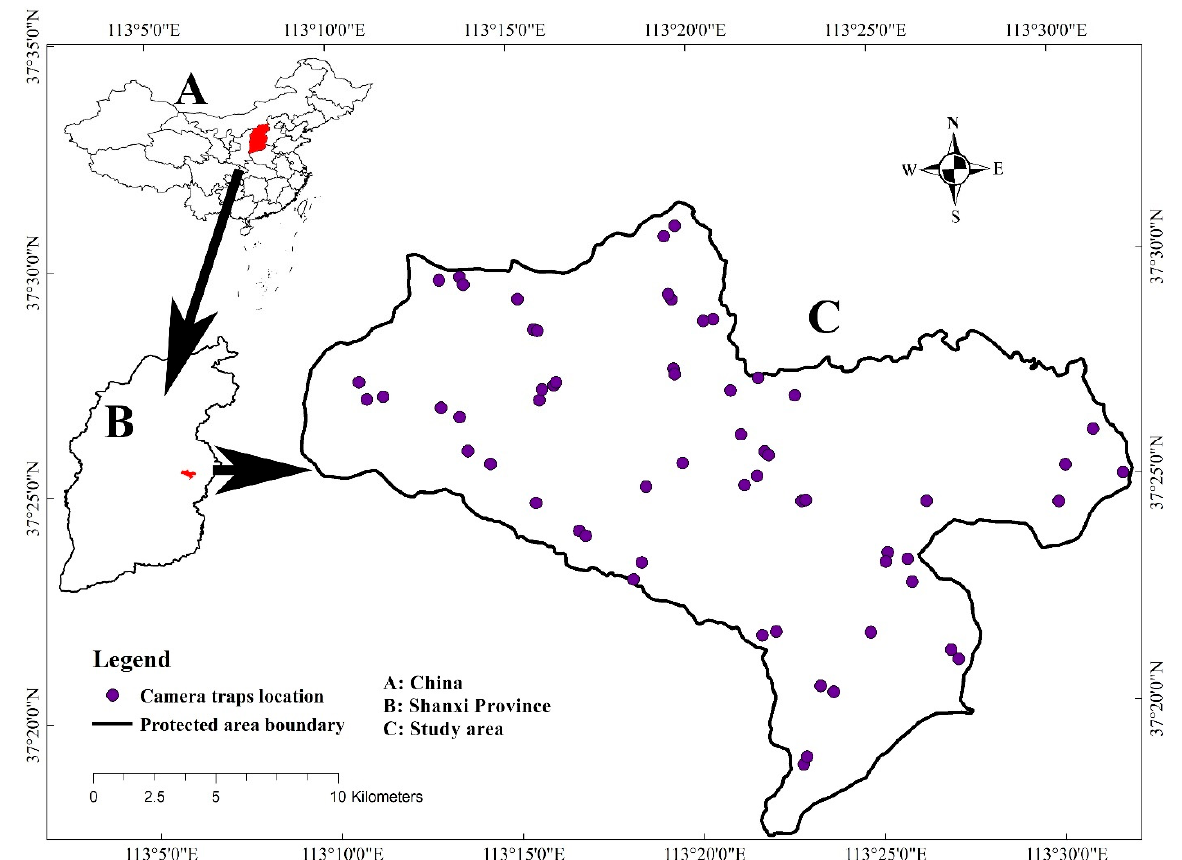
Figure 1. Illustration of study area and camera trap location. The study area is located in Tie Qiao Shan Nature Reserve, Shanxi Province, China.